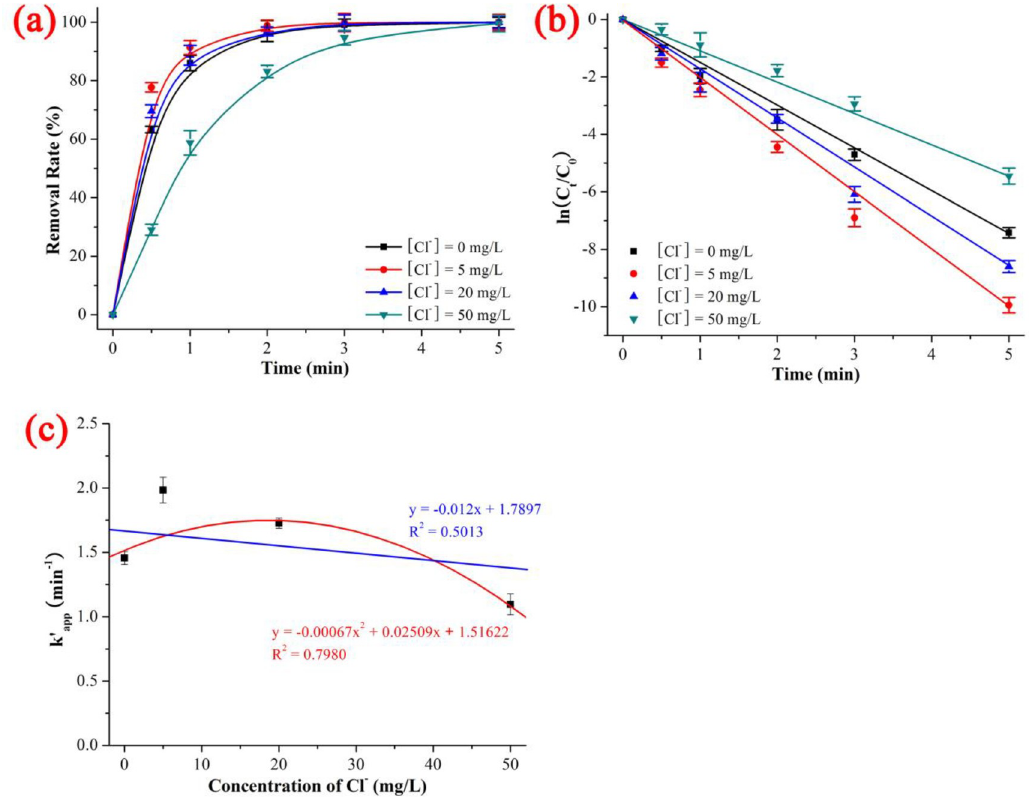
Fig 7. Effect of CO 32- on the removal rate (a), kinetics constant (b) and linear fitting between kinetics constant and concentration of CO 32- on the degradation of NIF via UV/H 2 O 2 . The error bars represent the standard deviation (n = 3).